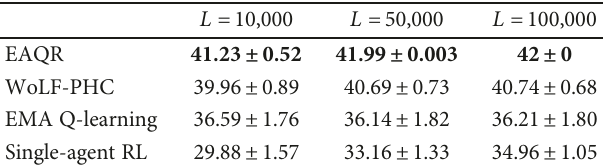
Table 7: Average steps for the DSN problem (evaluation episodes =5000).